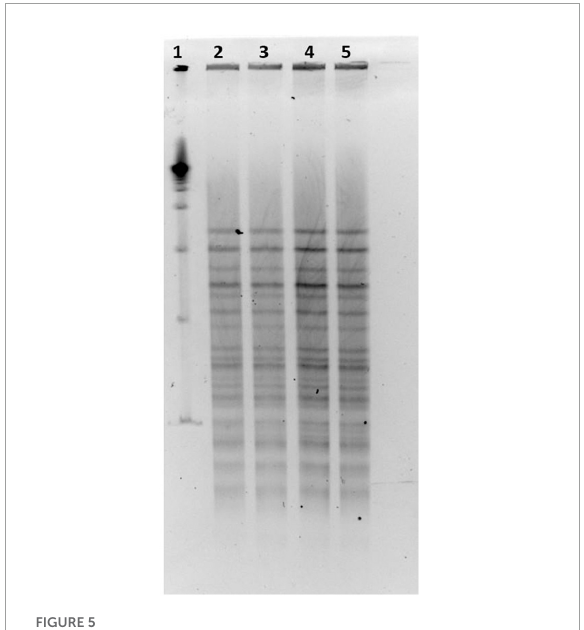
FIGURE5 (1) LP-CT strain PFGE profiles with Not I; 19 marker; (2) LP-CT 1 ◦ step at 30 ◦ C; (3) LP-CT freeze-dried at 30 ◦ C; (4) LP-CT 1 ◦ step at 37 ◦ C; and (5) LP-CT freeze-dried at 37 ◦